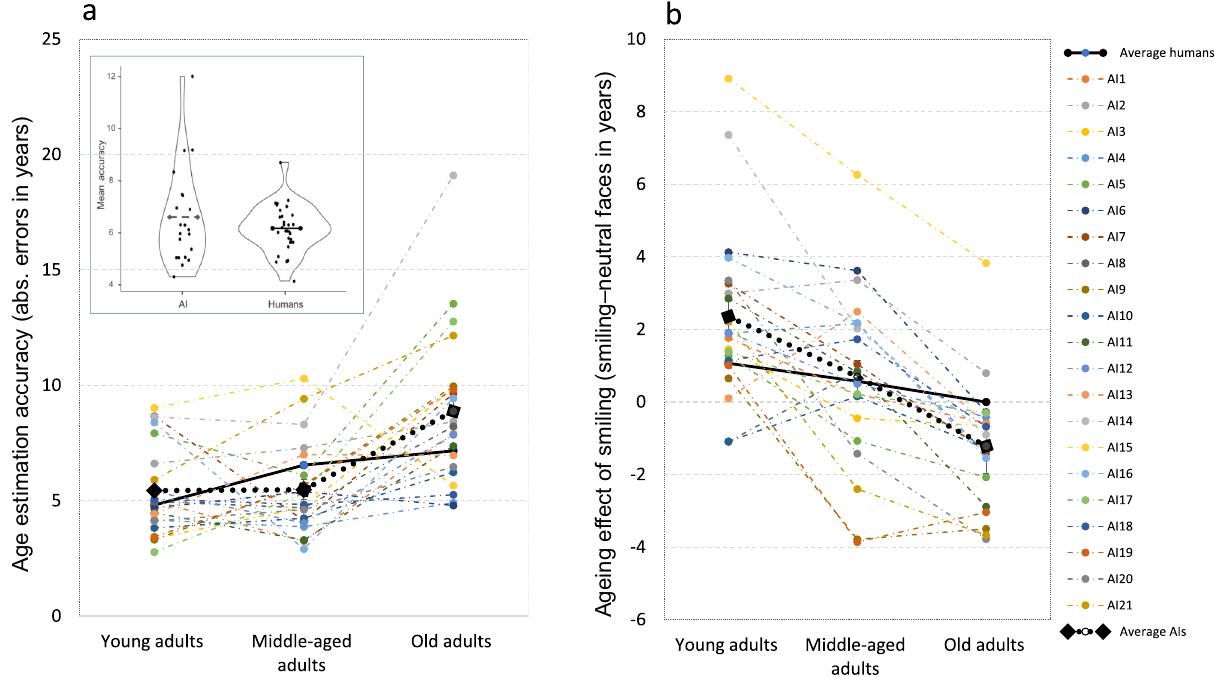
Figure 2. ( a ) Age estimation accuracy for the different AIs compared to average human performance. As was the case for human observers, AI performance showed a large decrease in accuracy for faces of older adults compared to faces of younger adults. This effect was larger for AI compared to human performance. ( b ) The ageing effect of smiling for the different age groups—smiling faces were estimated as older than neutral faces of the same people. Overall, this effect was larger for AI (younger adults), and showed a sharper decrease with age. The inset shows the mean accuracy data (across age group, gender and facial expression) for each AI and each of the human observers. Group averages are indicated by the horizontal lines. Although there was variability in age estimation accuracy in both groups, humans were less variable and more